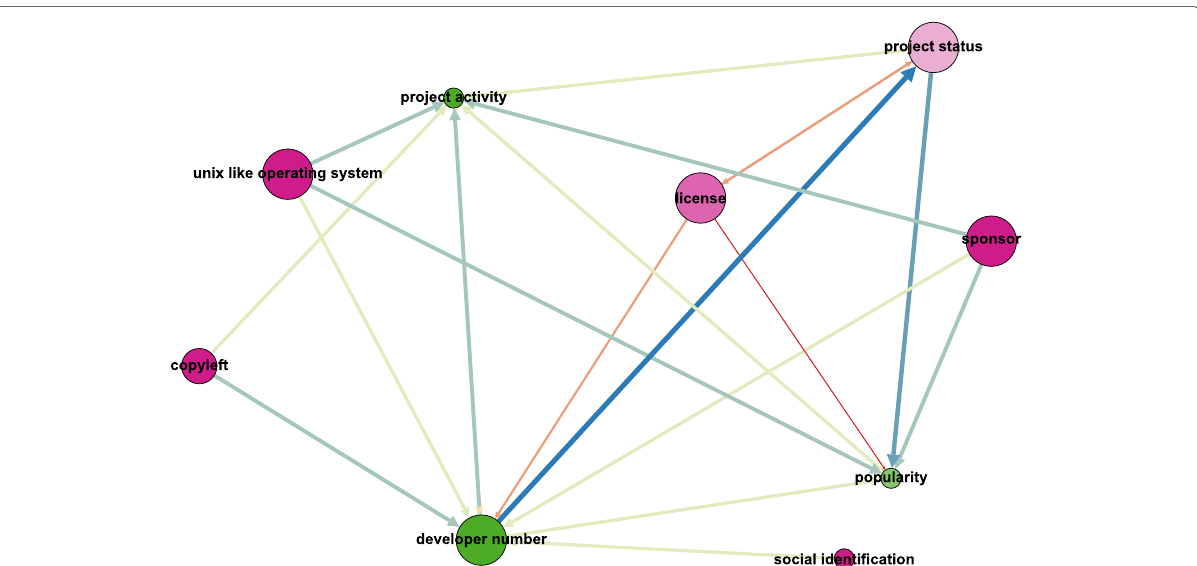
Fig. 3 This is the correlation figure of the developer number node intercepted from Fig. 2. All the attributes are the same as Fig.